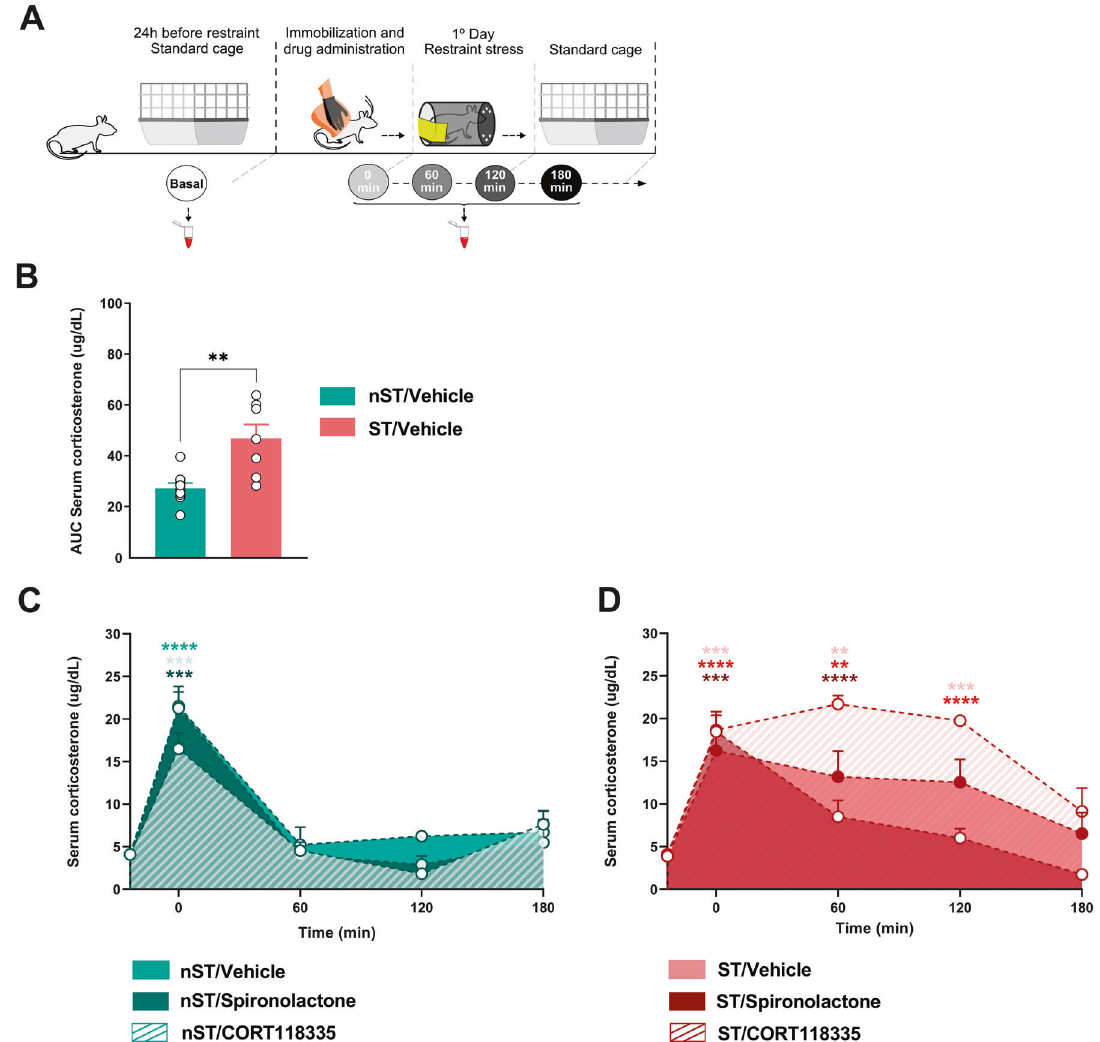
Fig. 1 Corticosterone concentration in restraint-stressed animals after infralimbic MR and GR modulation. Schematic representation of the experimental design ( A ). The area under the curve (AUC) of serum corticosterone concentration in restraint-stressed animals (ST) ( B ). Serum corticosterone concentration curve in unstressed animals (nST) subjected to IL-mPFC MR and GR modulation ( C ). Serum corticosterone concentration curve in stressed animals (ST) subjected to IL-mPFC MR and GR modulation ( D ). Results are represented as mean ± SEM ( n = 7 – 9 animals per group in B; n = 7 – 12 animals per group in C; n = 9-12 animals per group in D ). T-test ( B ). Two-way mixed-effects model ANOVA followed by Tukey ’ s test (C and D). In B, signi fi cant differences are indicated as ** ( p < 0.01) vs nST/Vehicle. In C and D, signi fi cant differences are indicated as **, ***, **** ( p < 0.01, p < 0.001, p < 0.0001, respectively) vs baseline. Spironolactone and CORT118335 at dose 10 ng. μ L − 1